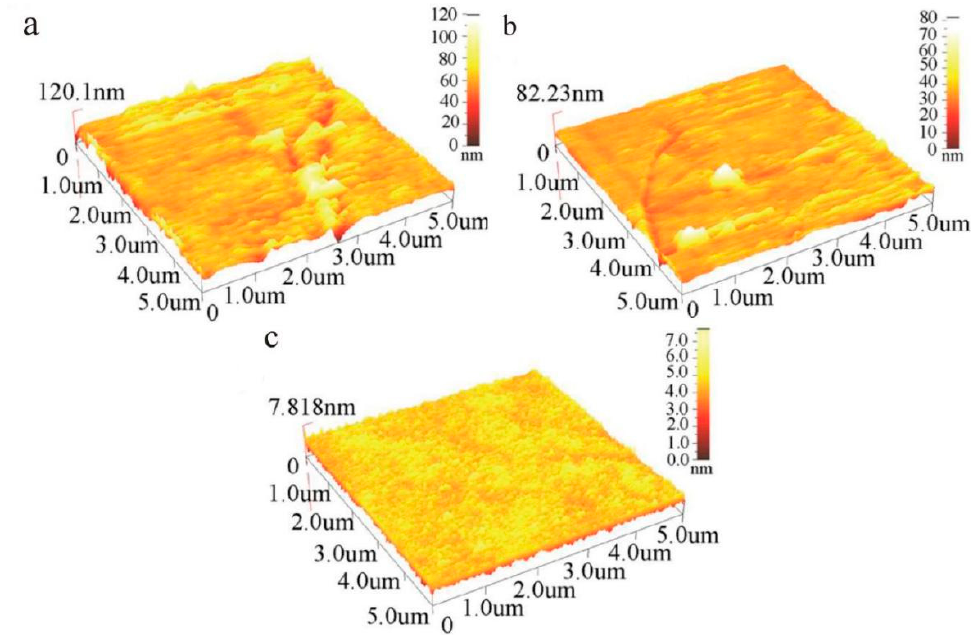
Figure 18. Atomic force microscope (AFM) images of blanket copper wafers: ( a ) before CMP, root mean square (RMS) roughness 8.47 nm, ( b ) after CMP by colloidal silica abrasive, RMS roughness 4.27 nm, ( c ) after CMP by PS@SiO 2 abrasive, RMS roughness 0.56 nm [16]. Reproduced with permission